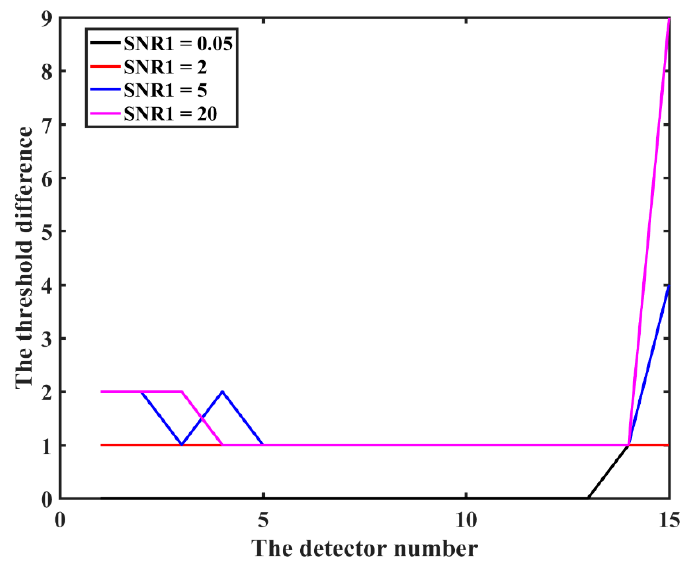
Figure 4. The influence from 2 SNR and 1 N on the threshold error for the same 1 SNR .